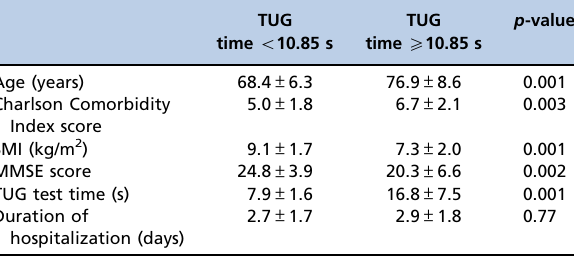
Table 3 - Intergroup comparisons of the Timed Up and Go test results at the point of greatest accuracy in the sample of 68 elderly hospitalized